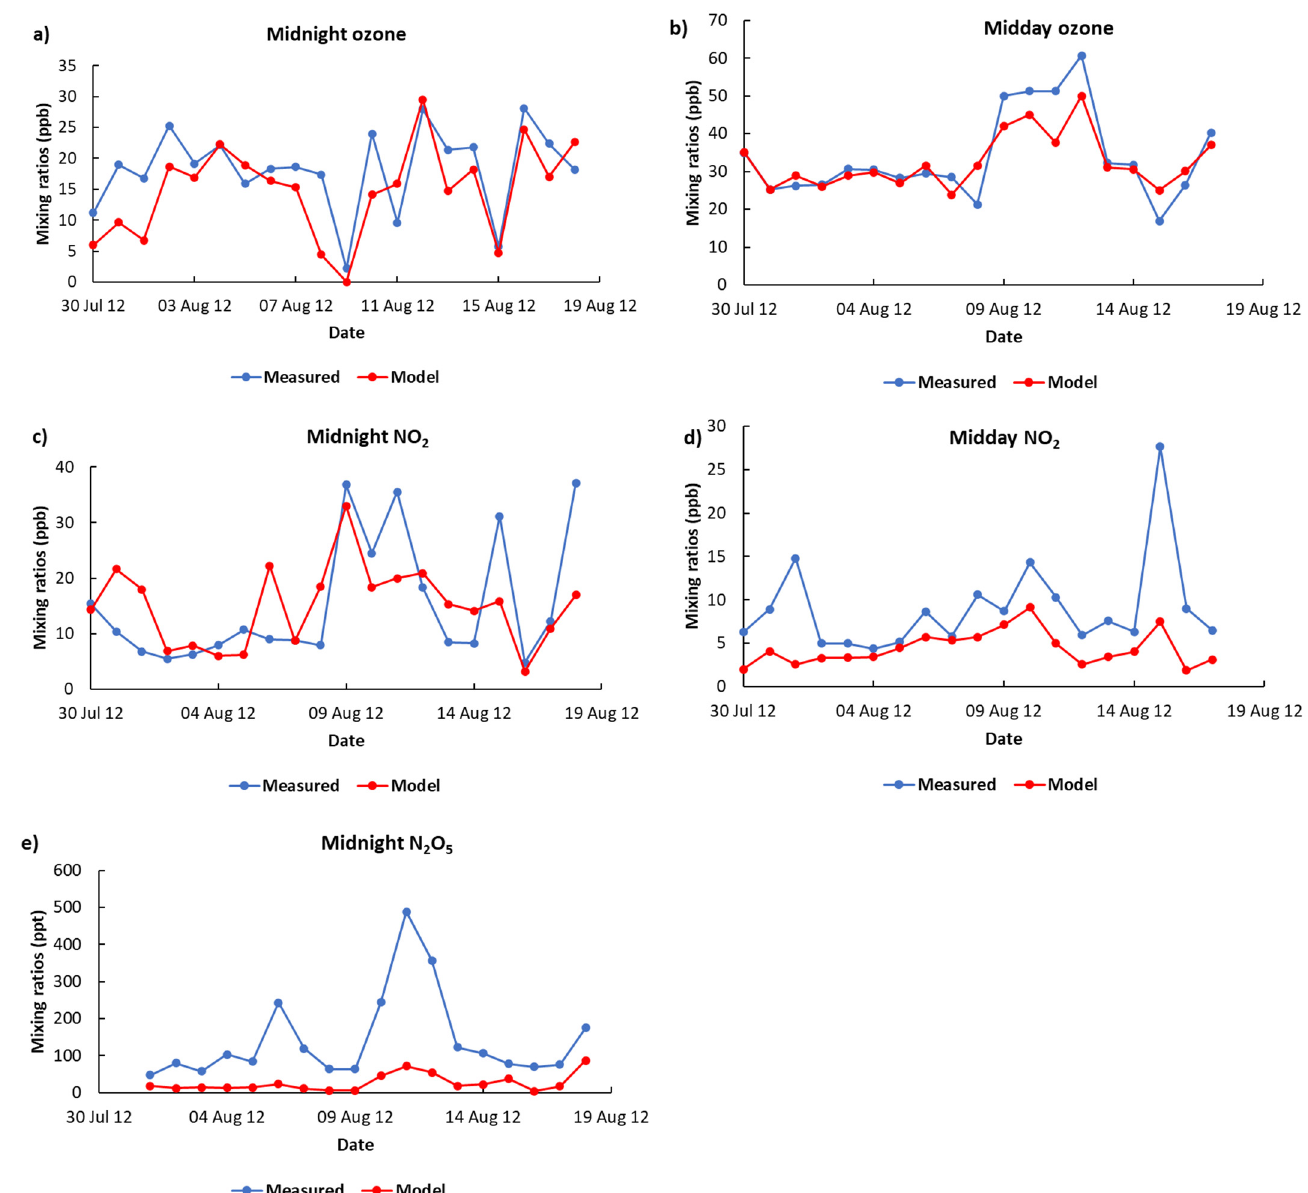
Figure 1. Comparison of ( a ) midnight ozone, ( b ) midday ozone, ( c ) midnight NO 2 , ( d ) midday NO 2 and ( e ) midnight N 2 O 5 mixing ratios modelled by WRF-Chem-CRI with those measured during the summer months of the ClearfLo project.